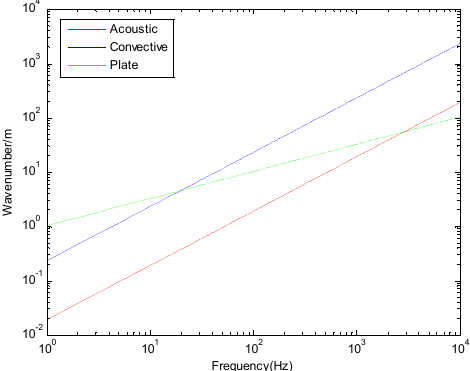
Figure 15. The wavenumbers. (Red curve, blue curve and green curve represent the wavenumbers of the acoustic component, the convective component and the panel, respectively).